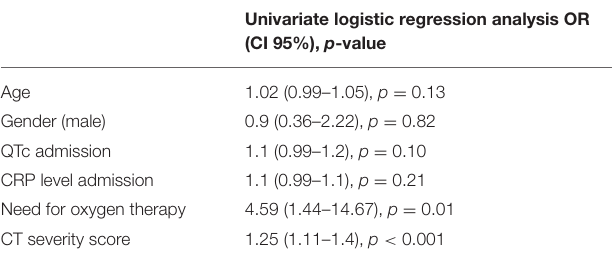
survminer (25) packages on R software.